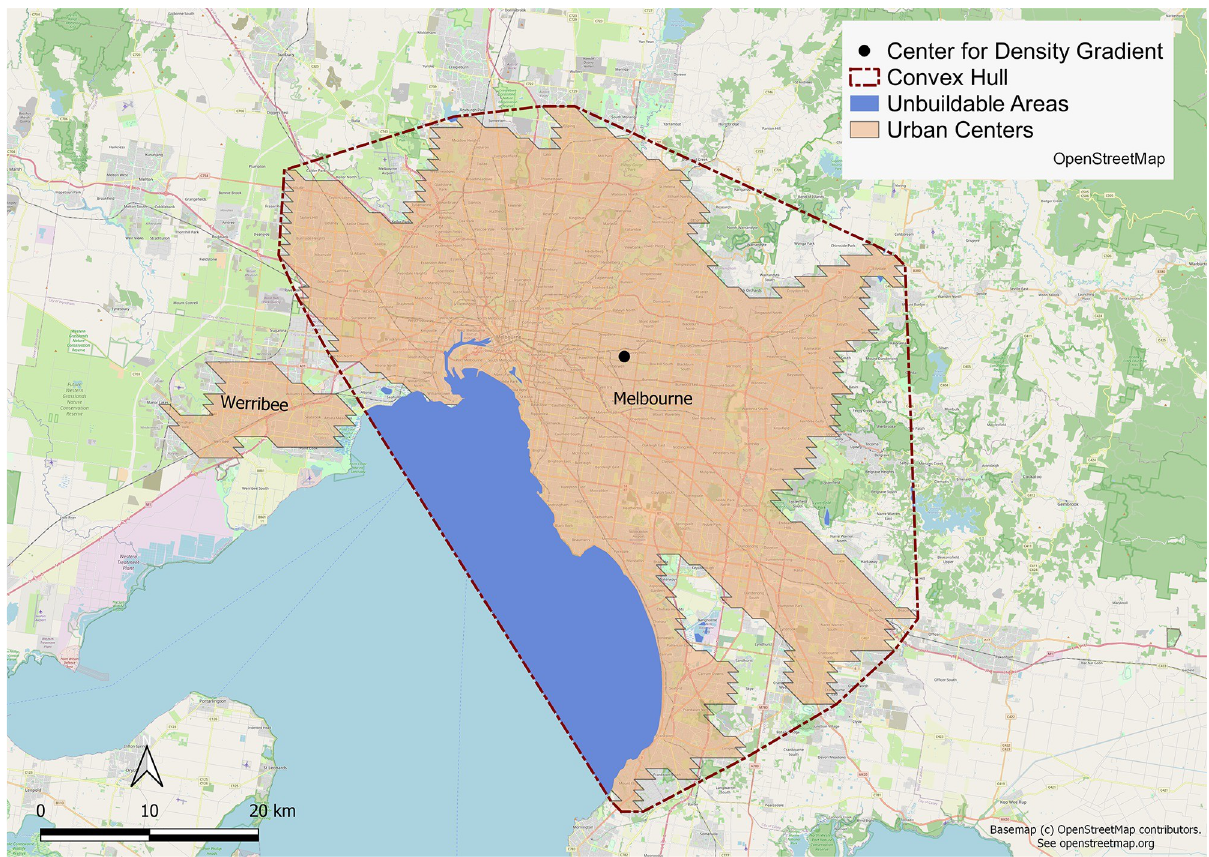
Fig 2. The convex hull of Melbourne, the unbuildable areas within the convex hull, and the center for density gradient. Base map and data from OpenStreetMap and OpenStreetMap